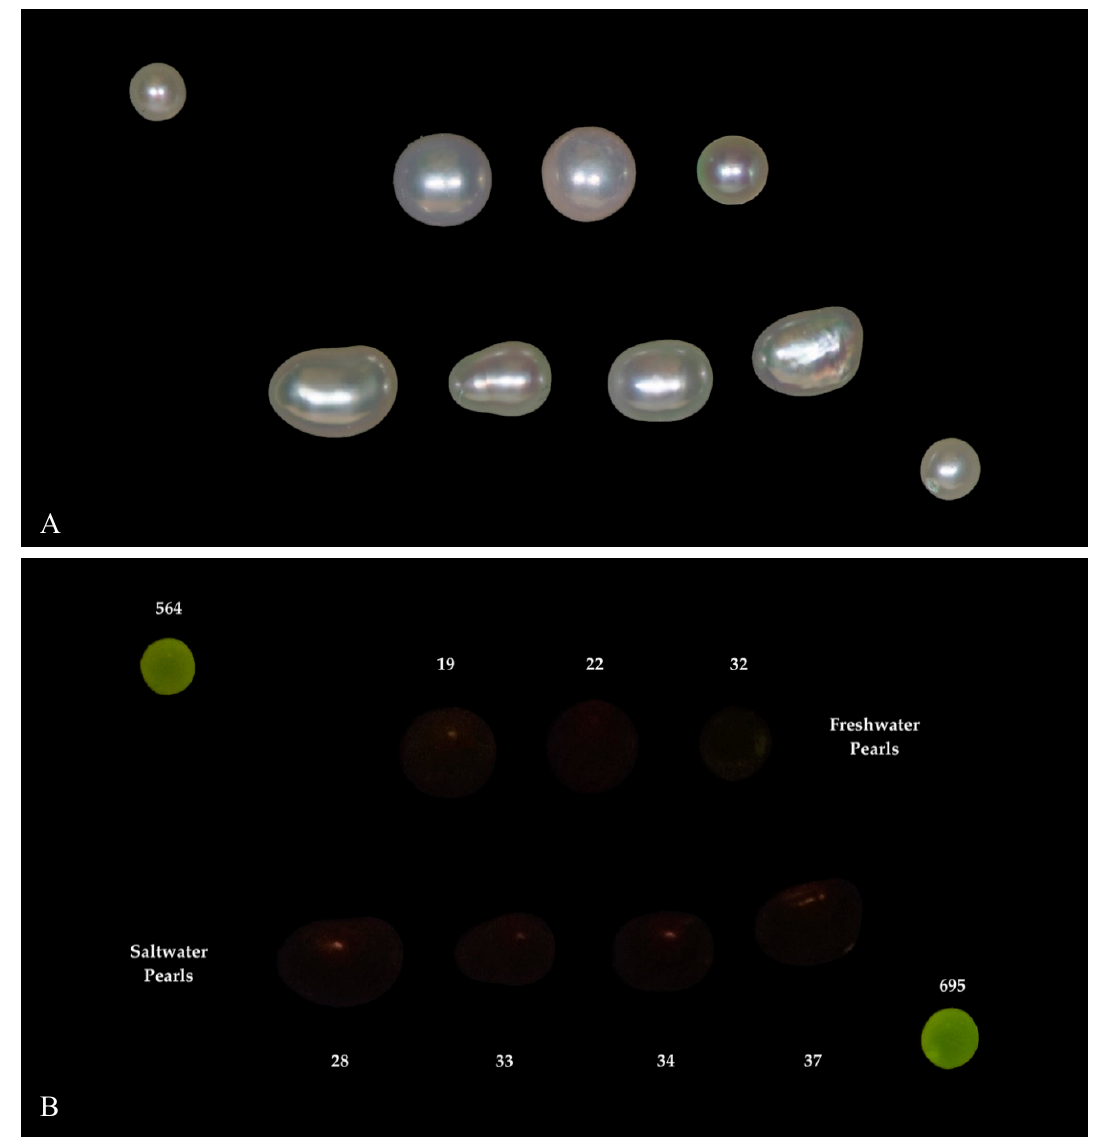
Figure 9. Three freshwater (upper row) and four saltwater (bottom row) samples under daylight ( A ) and under X-rays ( B ). The two freshwater samples upper left (diameter: 2.85 mm) and bottom right (diameter: 2.95 mm) used as reference. All samples present similar luminescence intensity and separation of freshwater samples from saltwater is challenging. The concentrations of 55 Mn in ppmw are mentioned. For the samples 3 analyses with LA-ICP-MS that were acquired, the average values are presented (rounded to the nearest one).